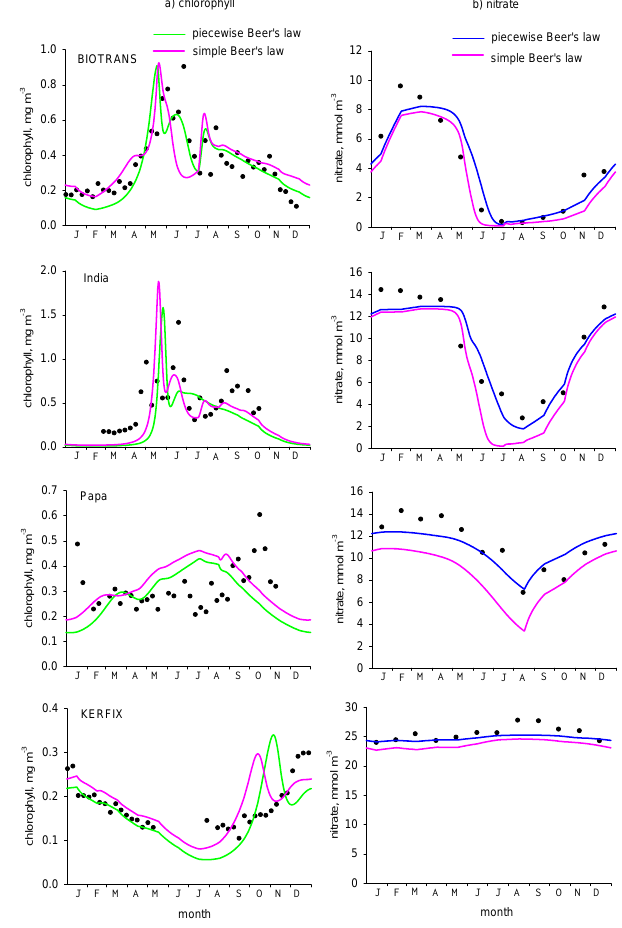
Figure 18. Model simulations for all four stations showing sensitiv- ity to choice of method for calculating light attenuation in the water column: (a) piecewise Beer’s law (Eq. 10), (b) simple Beer’s law (Eq.